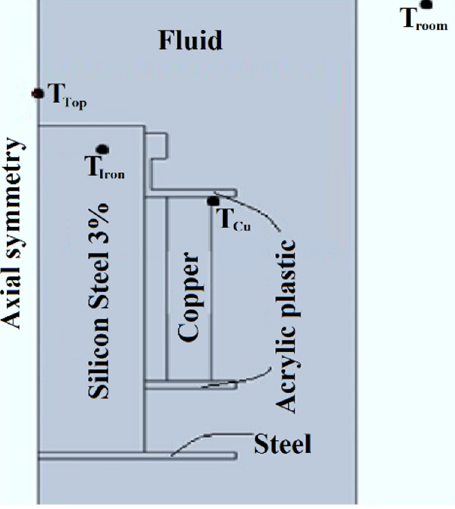
Figure 3. Section of the experimental transformer in the setup.